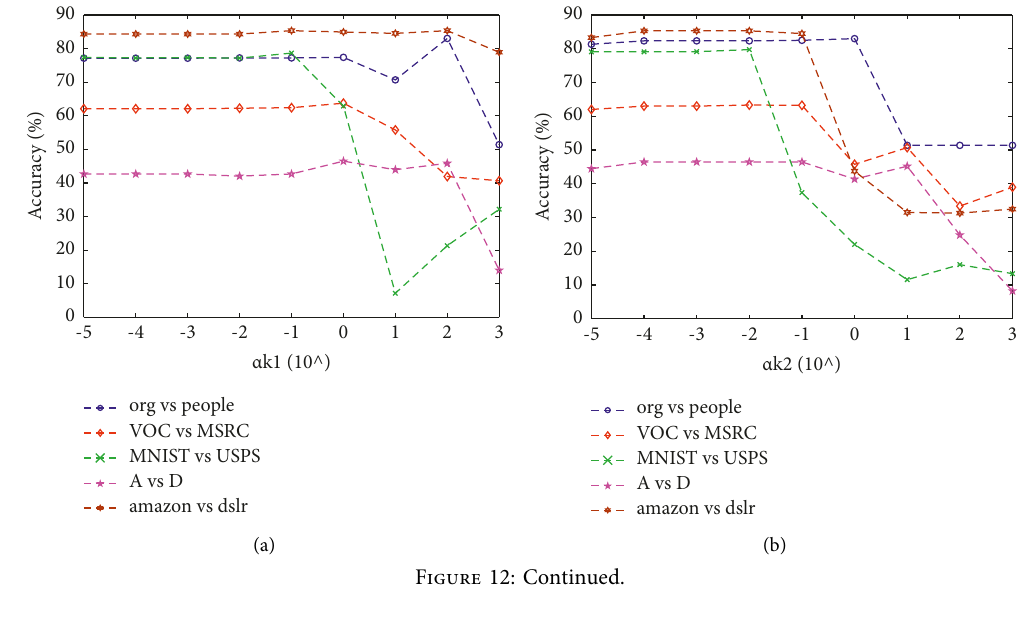
, α , and λ on the accuracy of 1 2 1